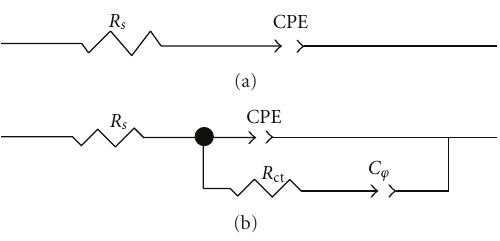
Figure 2: Equivalent circuits used for approximation of the EIS data. (a) The bare GC and (b) GC/RuOHCF/RuHCF electrodes in the absence of external